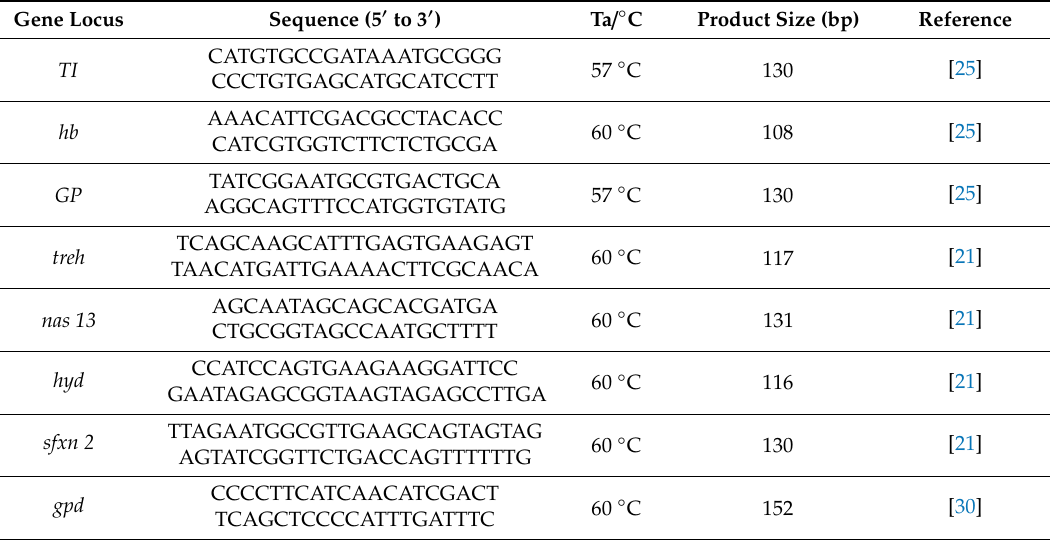
Table 1. Primers sets of target genes used in quantitative real-time PCR (qPCR)